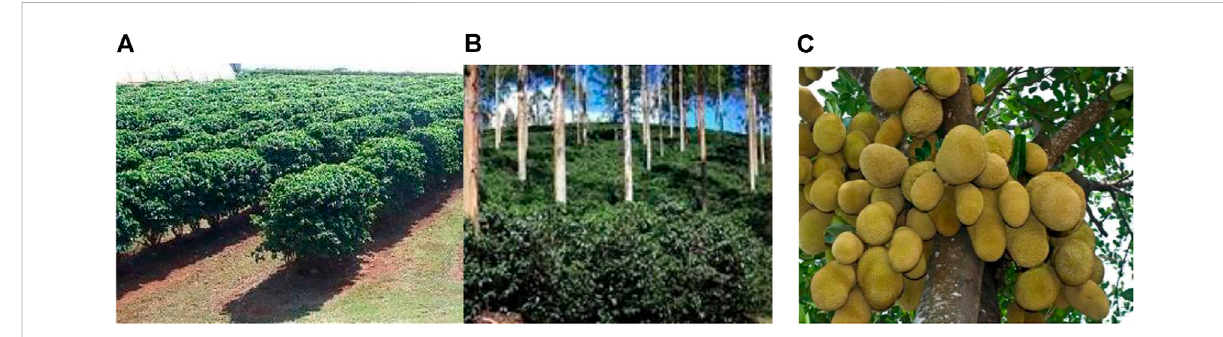
FIGURE 2 (A) CoffeePlantations without shadetrees (B) with shadetrees (C) Fruitbearingjackfruittree.1)(Image Credit J. Stephen Conn islicensed